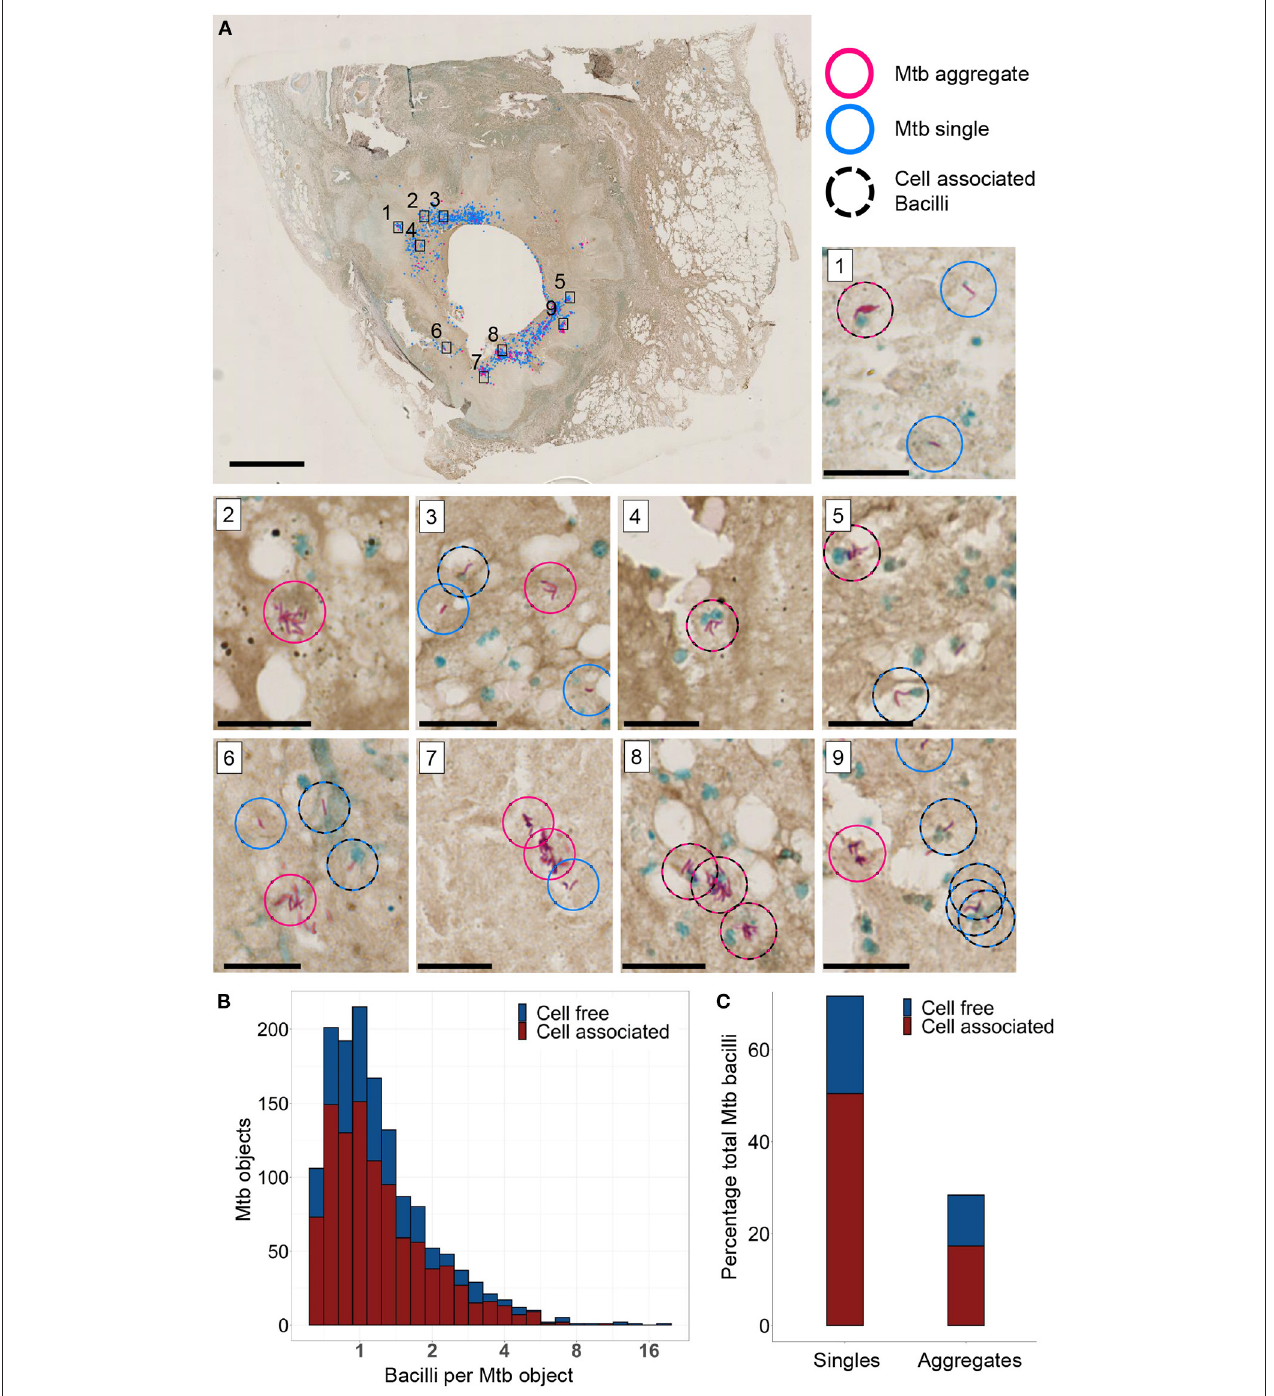
FIGURE 6 | Mycobacterium tuberculosis (Mtb) and Mtb aggregates are found near the periphery of a TB cavitary lesion. (A) Ziehl-Neelsen stain of a lung section. Aggregated bacilli are highlighted with a red circle and single bacilli with a blue circle. Scale bar is 3 mm. A black dashed circle is overlaid if the Mtb are in close proximity to a cell nucleus (blue stain). Sub-areas 1–9 are magnified in separate panels. Scale bars are 20 µ m in the sub-areas. (B) Stacked histogram of the number of Mtb objects with varying numbers of Mtb bacilli found to be cell free or cell associated. (C) Stacked histogram of the total number of Mtb observed to be single bacilli or aggregates, and were found to be in close association with host cell